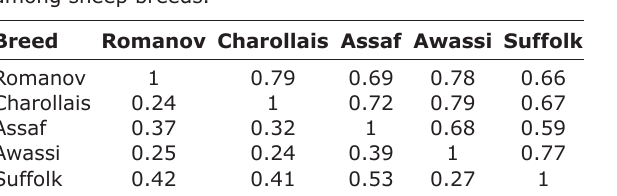
Nei’s genetic identity (above diagonal) and genetic distance (below diagonal)